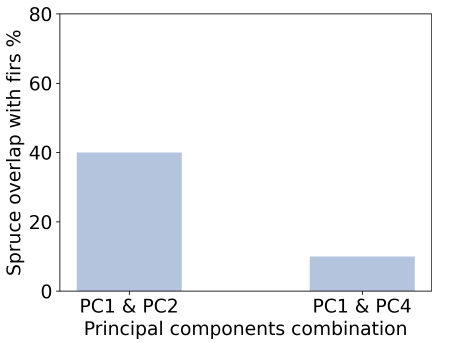
Figure 11. PCA coupled with k -means clustering results for the PC1 and PC4 pair, including the 90%/10% synthetic mixtures.